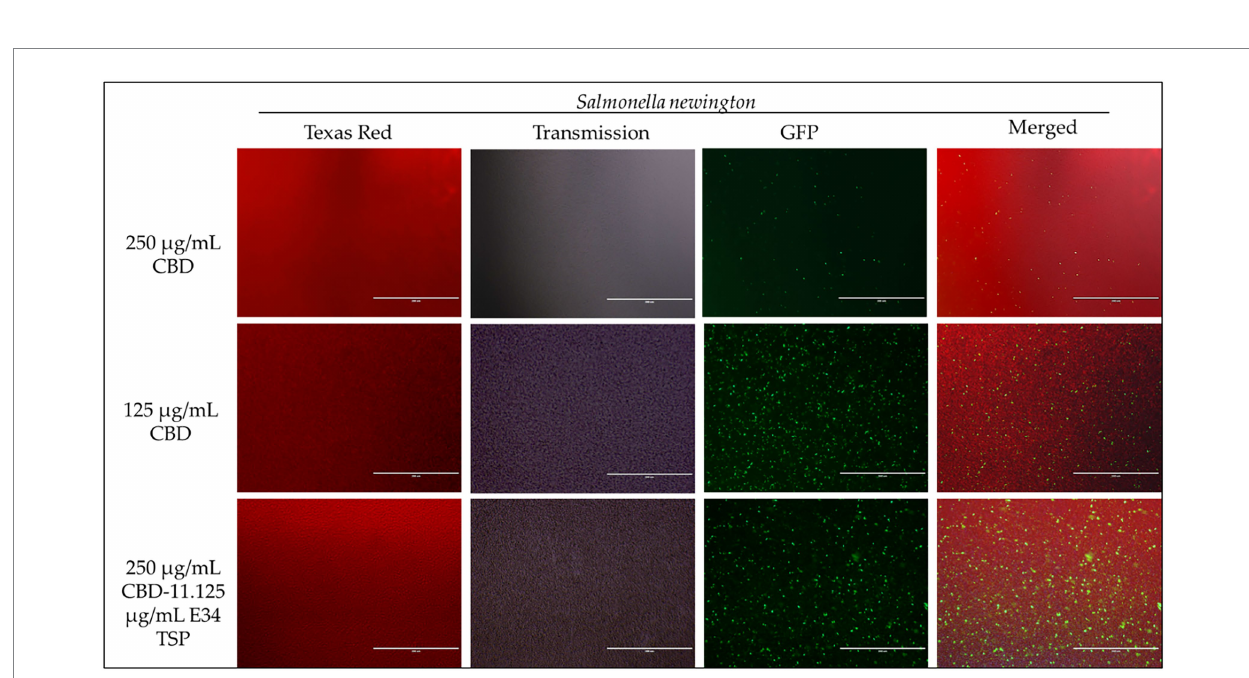
FIGURE 7 Immunofluorescence analysis of S . Newington (SN) at higher concentrations of CBD extract (250 μ g/ml, 125 μ g/ml, and 250 μ g/ml + 11.125 μ g/ml E34 TSP) treatments. Generally, there is observed higher killing of S . Newington in all treatments. Comparatively, there seems to be an observed lower killing of S . Newington at the combination treatment.